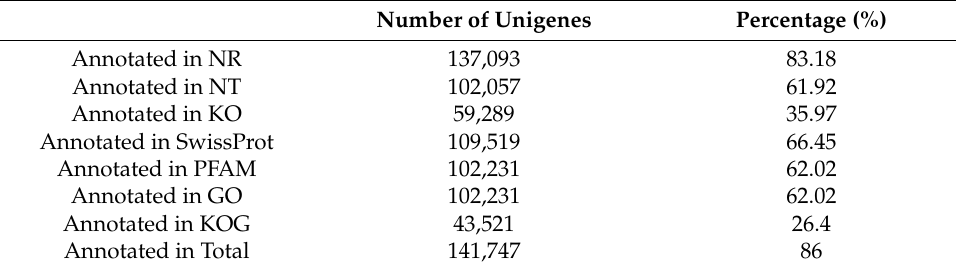
Clusters of Orthologous Genes (COG) and the Kyoto Encyclopedia of Genes and Genomes (KEGG) using BLASTX. InterProScan5 annotated InterPro domains and functional assign- ments were mapped onto the Gene Ontology (GO) database. Figure 3B and Table 2 show that 86.0% (141,747) of unigenes were annotated in at least one database. As shown in Figure 3C, 33,349 unigenes are commonly annotated in five public databases. After aligning with all the genes in the databases, Coffea canephora (77.8%) showed the highest number of best hits (Figure 3D). It is pretty consistent with phylogenesis. Since both C. canephora and U. rhynchophylla belong to the Rubiaceae family, and C. canephora is the closest to U. rhynchophylla with sequenced genomic resources. Table 2. Summary of unigenes’ annotations of U. rhynchophylla .